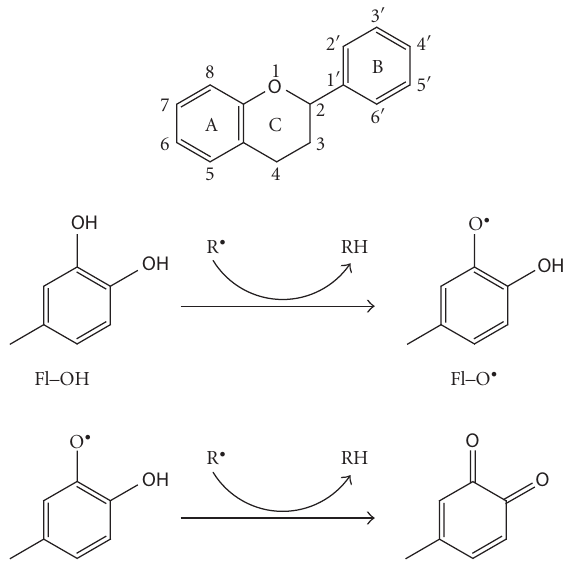
Figure 1: (a) Basic structure of a flavonoid, a C15-skeleton showing the A, B, and C ring, reproduced from [34]. (b) Scavenging of ROS (R • ) by flavonoids, reproduced from